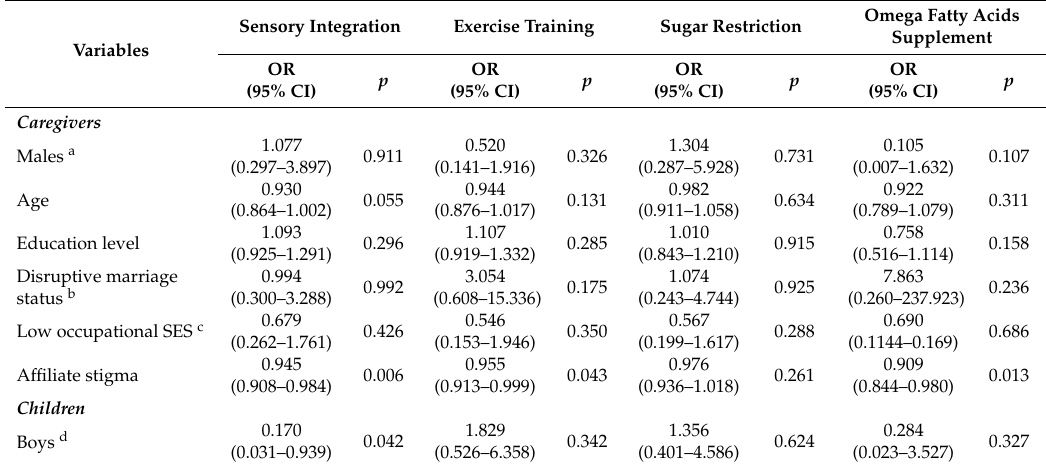
Table 4. Factors related to the e ff ectiveness of CAIS for ADHD evaluated by